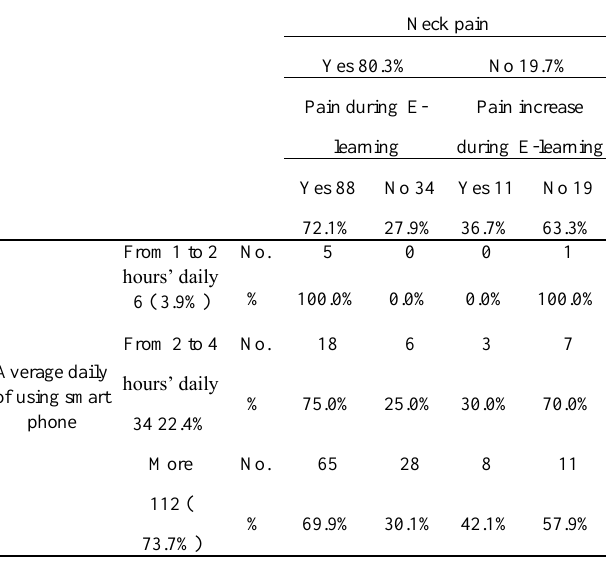
Table (5): Show the correlation between the daily average of using smart phone and neck